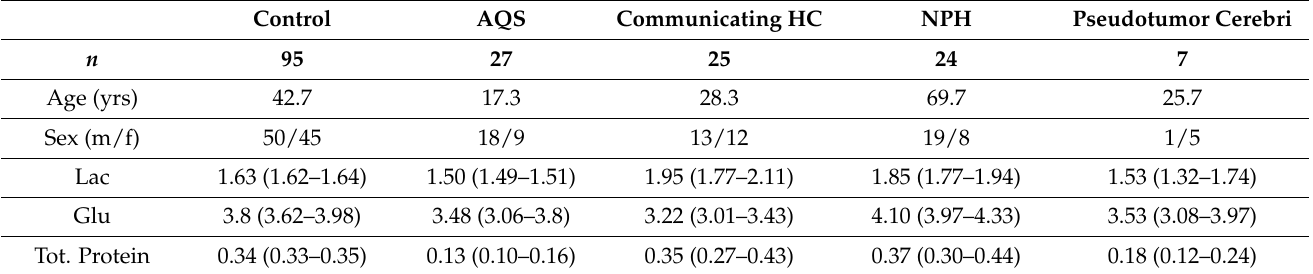
Table 1. Overview of demographic data and CSF analysis data for all